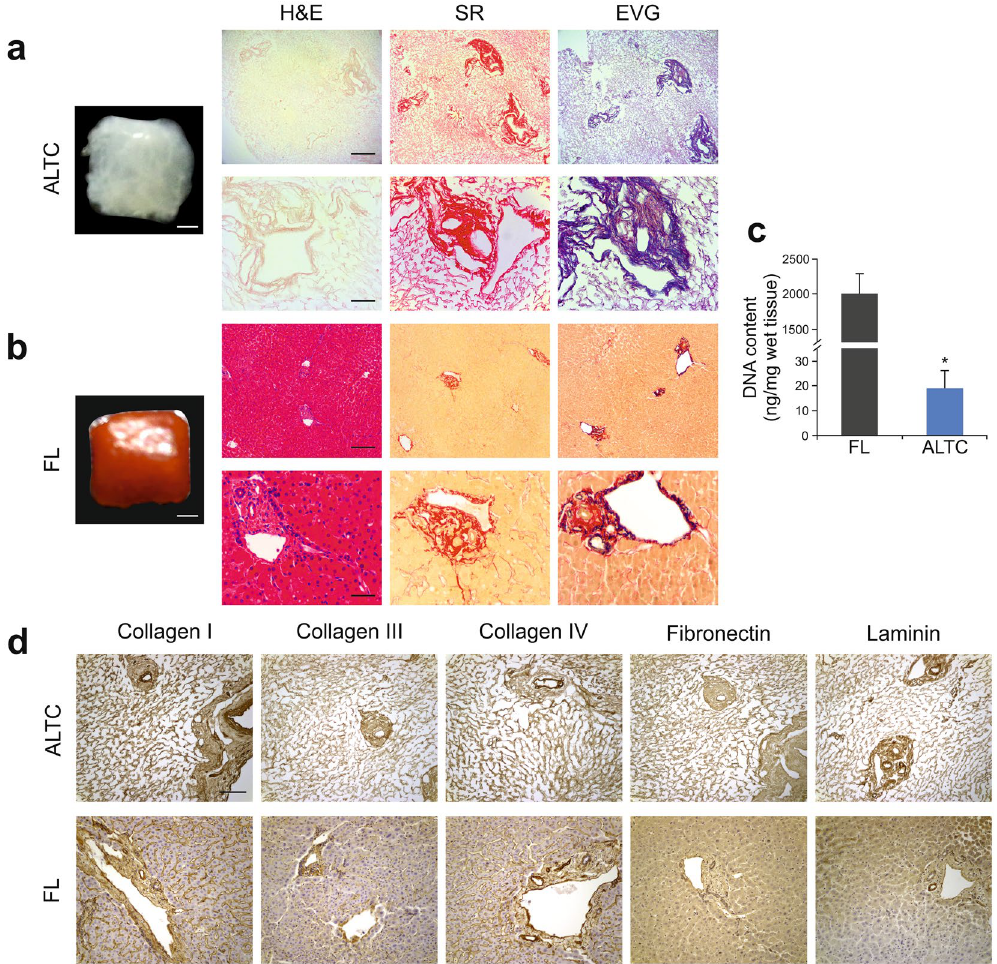
Figure 1. Decellularization of human liver cubes. ( a ) Macroscopic appearance and histological analysis after decellularization, confirming elimination of nuclear (blue; H&E) and cellular material (yellow; SR) and preservation of collagen (red; SR) and elastin (blue/black; EVG). ( b ) Macroscopic appearance and histological images of fresh human liver. ( c ) DNA quantification showing significant elimination of DNA in the decellularized cubes. ( d ) Comparison of the expression and distribution of several ECM proteins, namely collagen I, collagen III, collagen IV, fibronectin and Laminin, evaluated by immunohistochemistry showing consistency between decellularized cubes (top panel) and fresh samples (bottom panel). Data are expressed as mean ± s.d. *** p < 0.0001. Scale bars, 1 mm macroscopic images ( a , b) or 200 μ m top panel; a, b or 50 μ m bottom panel; a, b or 100 μ m ( d ). Biological replicates (n = 16) are performed for all